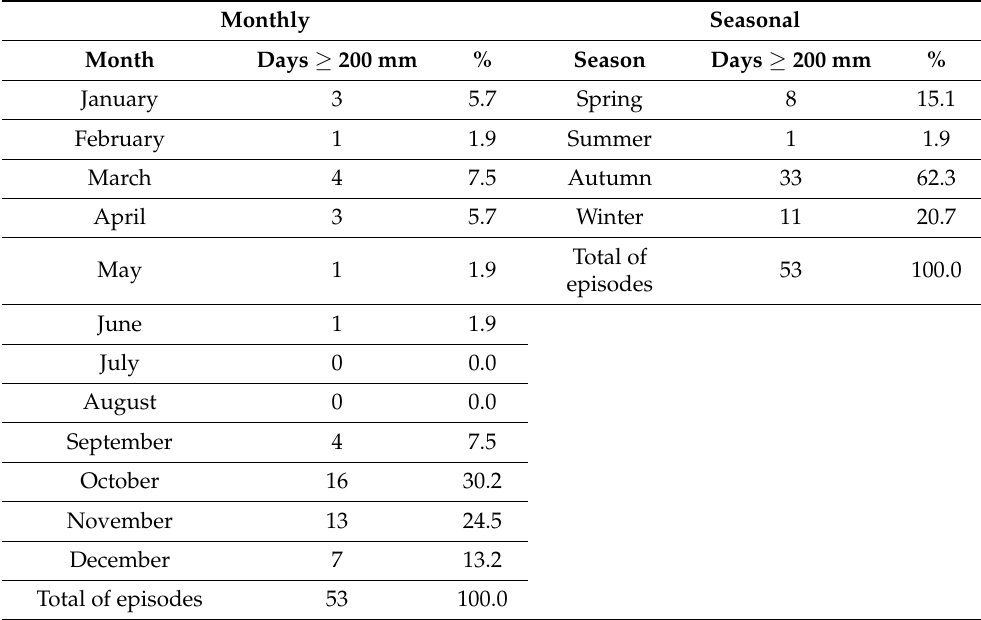
Table 1. Monthly and seasonal distribution of the 53 days with over 200 mm of rainfall in the Balearic Islands. Monthly